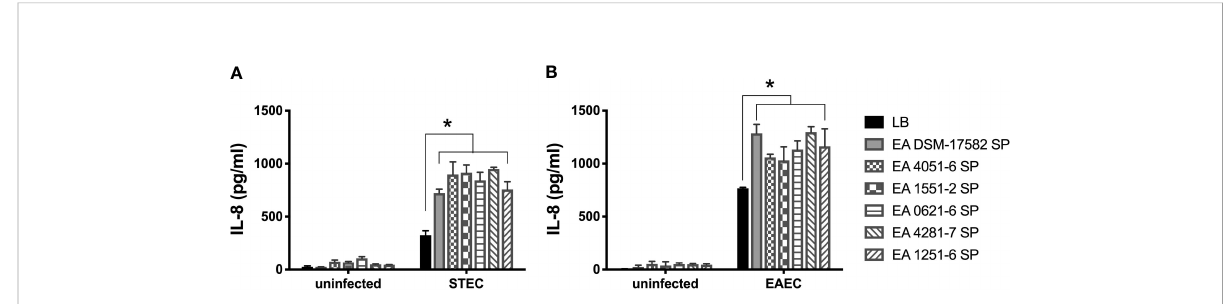
FIGURE 4 Induction of IL-8 secretion by DEC pathotypes in the presence of EA SP from clinical strains. T84 cells were infected with STEC (A) or EAEC (B) in the presence of the supernatant obtained from fi ve clinical E . albertii strains (4051-6; 1551-2; 0621-6; 4281-7; 1251-6) and a reference strain (DSM-17582). We used uninfected cells incubated with the different EA SP as a negative control. Three hours post-infection, the level of IL-8 secretion was evaluated by ELISA. Graphed data are the mean of one representative experiment performed in triplicate, with the error bars indicating standard deviation. * p < 0.05 by ANOVA and multiple comparison